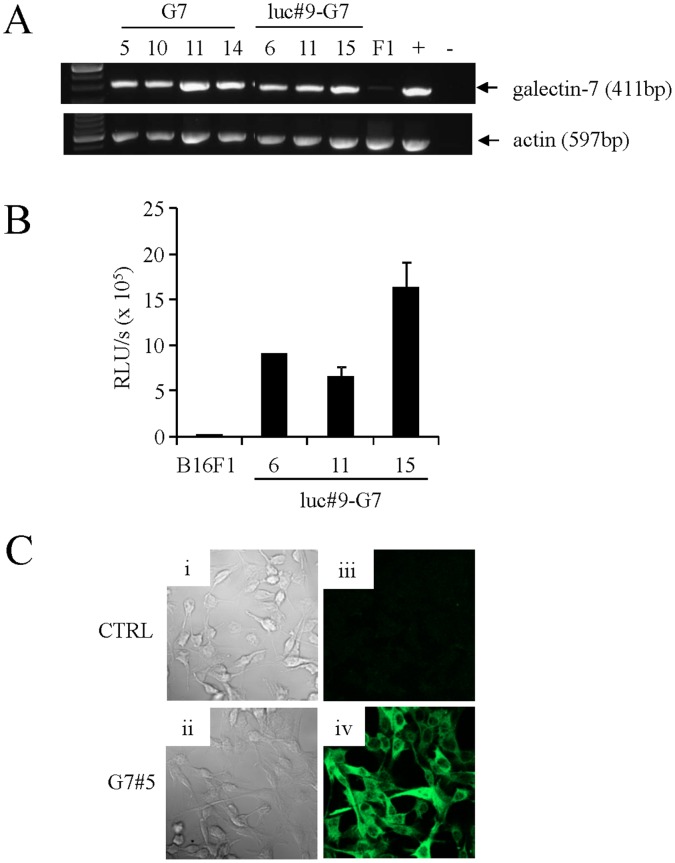
Validation of B16F1 transfectants overexpressing luciferase and/or galectin-7.A) RT-PCR analysis for galectin-7 mRNA expression in transfectant cells overexpressing galectin-7 with or without luciferase in comparison with a control B16F1 cell line (F1). The aggressive murine lymphoma cell line S19 (+) was used as a positive control. Actin was used as a loading and specificity control. B) Luciferase assay of three B16F1 transfectant cell lines overexpressing luciferase and cotransfected with pRc-CMV2-galectin-7 in comparison with the control B16F1 cell line. C) Confocal microscopy for galectin-7 in control B16F1 cells (iii) and galectin-7 transfectant cells (G7#5) (iv); these cells were also visualized (i, ii).